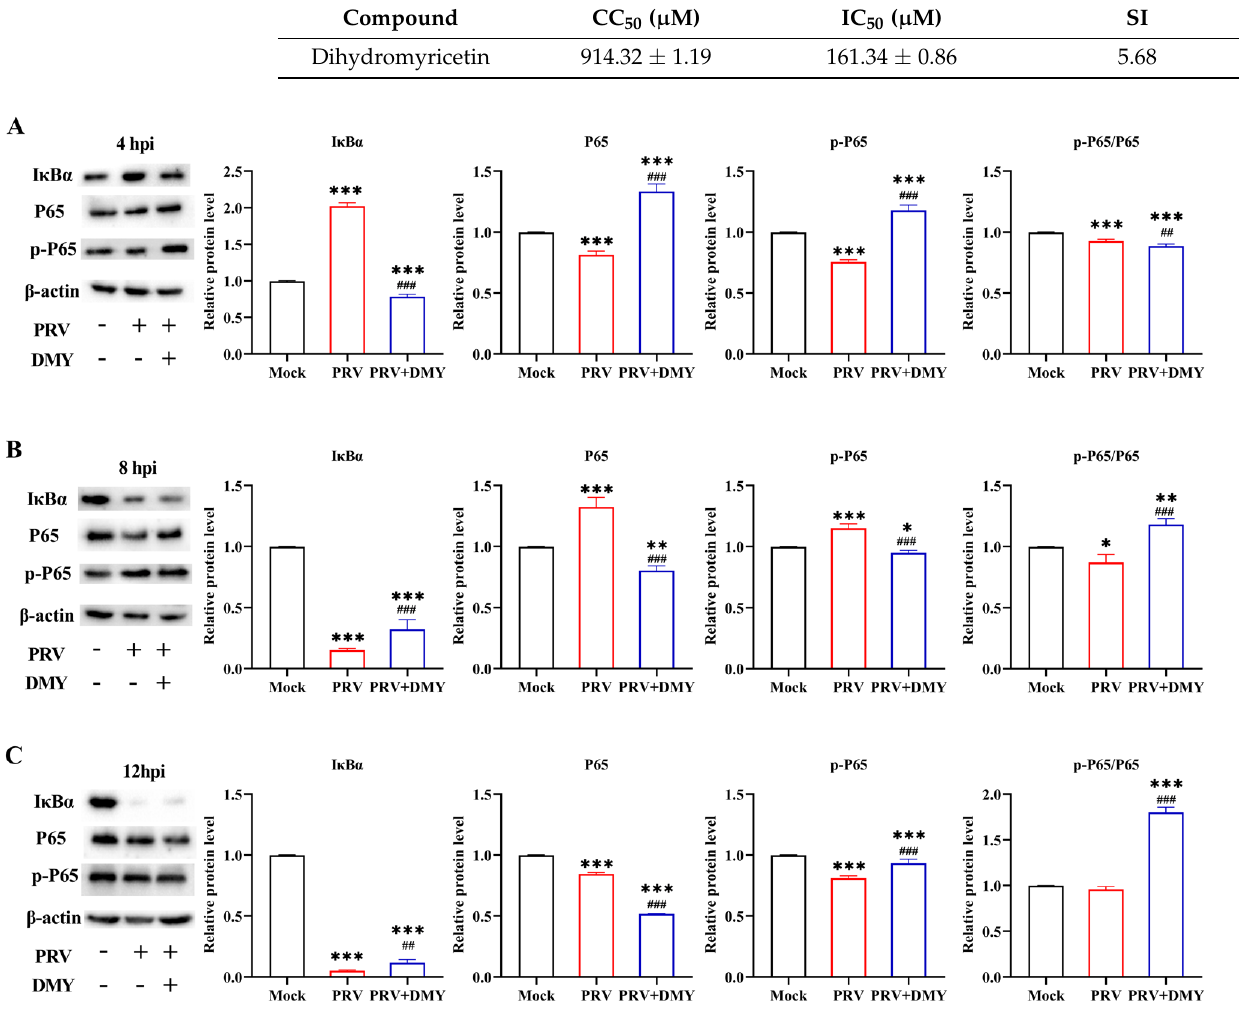
Figure 3. The effects of dihydromyricetin on the NF- κ B signaling pathway during 4 hpi ( A ), 8 hpi ( B ), and 12 hpi ( C ). PK-15 cells treated or untreated with DMY (500 µ M) were infected with PRV (MOI = 1), and the expressions of pathway-related proteins, including I κ -B α , P65 and p-P65, were ex- amined by western blotting. Mock, normal cell groups; PRV, virus-inoculated group; PRV + DMY, virus-inoculated and treated group. Compared with the mock group, symbols *, ** and *** denote p < 0.05, p < 0.01 and p < 0.001, respectively. Compared with the PRV group, symbols ## and ### de- note p < 0.01 and p < 0.001, respectively. The uncropped western blot in Supplementary